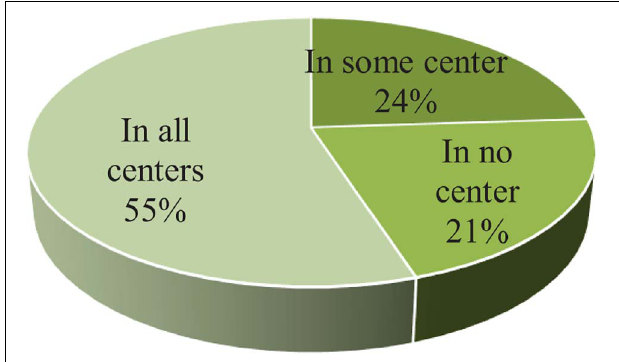
FIGURE 2 | Budgetary and management control dimensions of ONCE. Source: Authors.